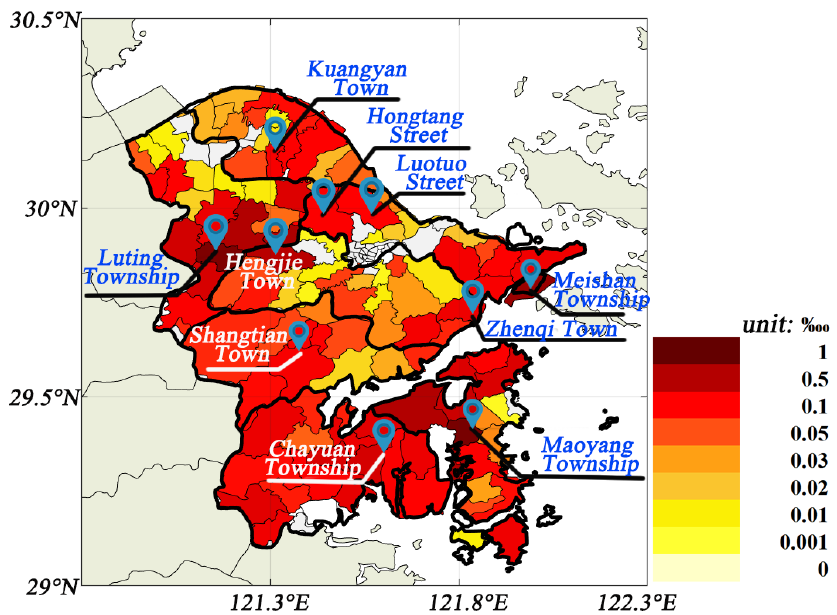
Figure 10. Total insured loss rate of rural housing due to typhoons by townships in Ningbo (2014 – 2019).